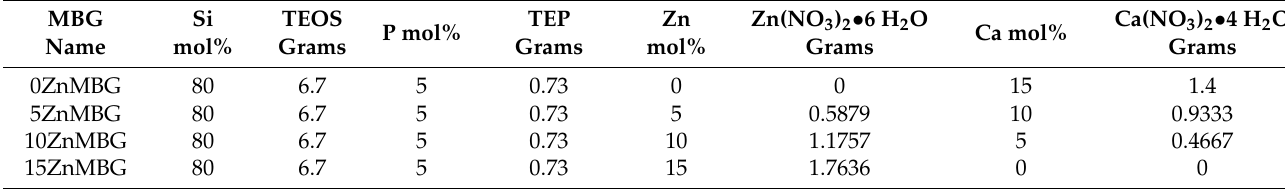
Table 1. Preparation and content of different